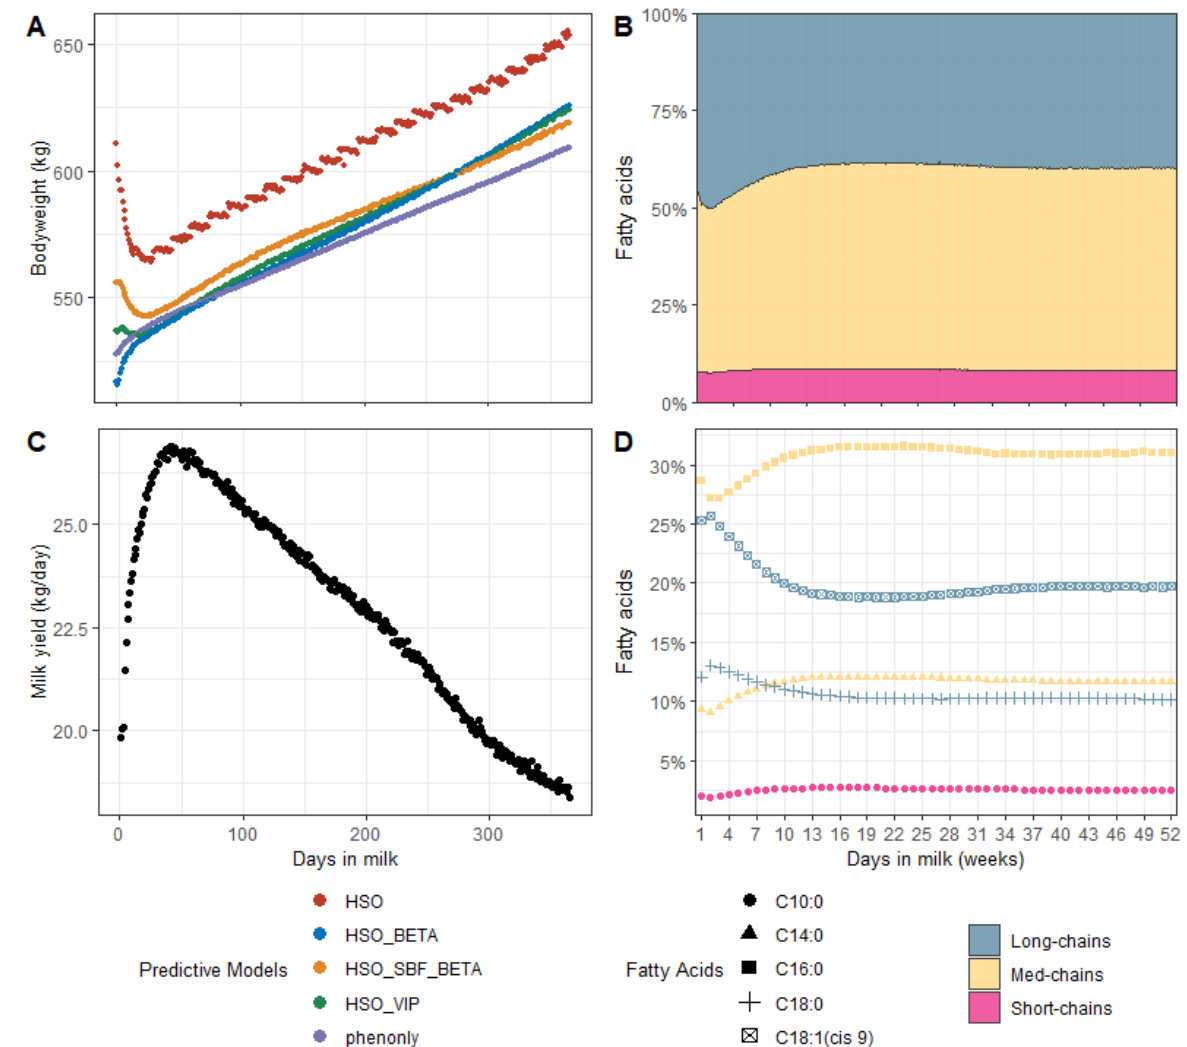
Figure 3. Evolution of the predicted bodyweight ( A ), the predicted content of some fatty acids groups in fat ( B ), the milk yield ( C ), and the predicted content of some individual fatty acids in fat ( D ). HSO is the shortcut that subsets of features used by Soyeurt et al. (2019), while phenonly stands for a subset containing only milk yield, parity and DIM.